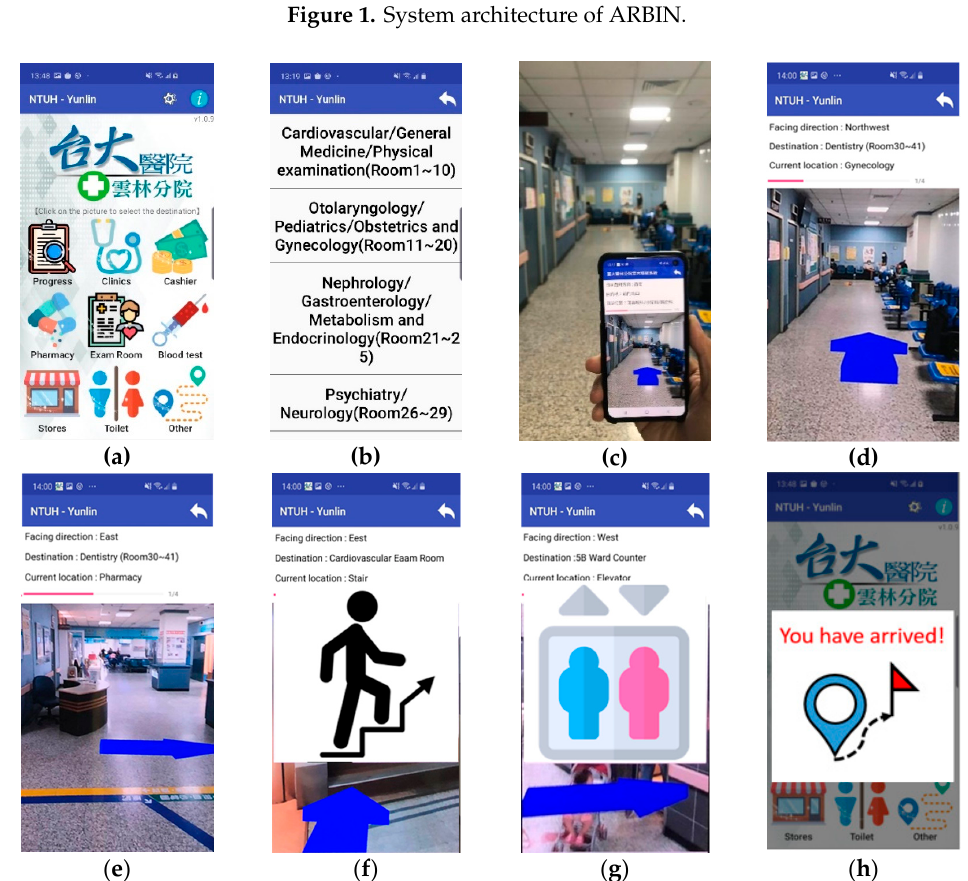
Figure 2. The user interface of ARBIN. ( a ) Main page of ARBIN; ( b ) Destination list; ( c ) Start